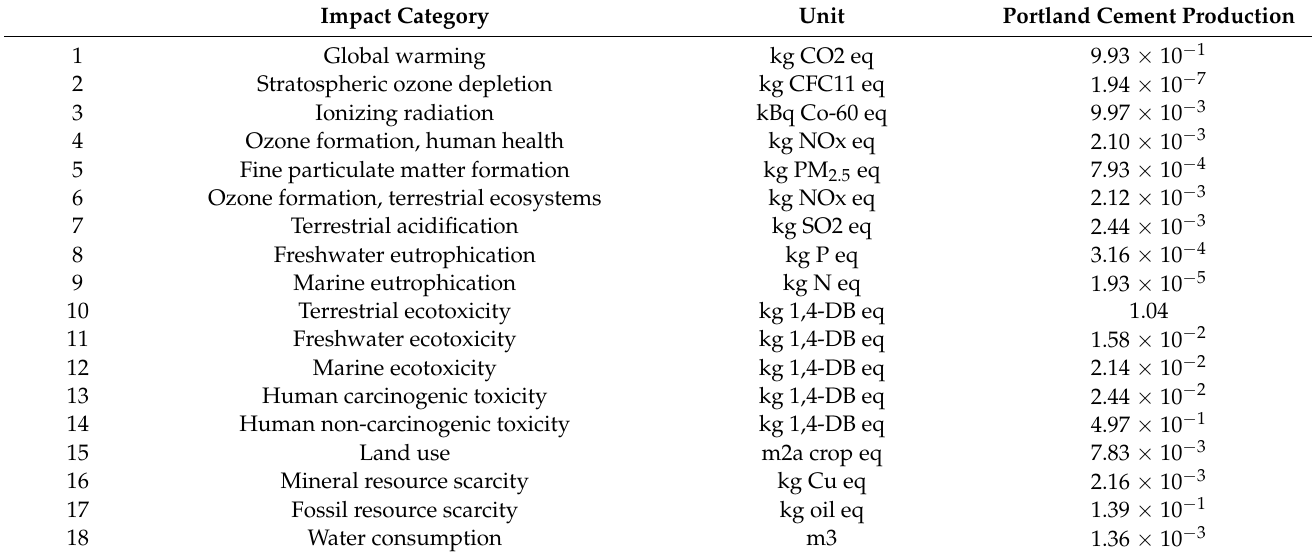
Table 4. The characterization midpoint method based on 1 kg Portland